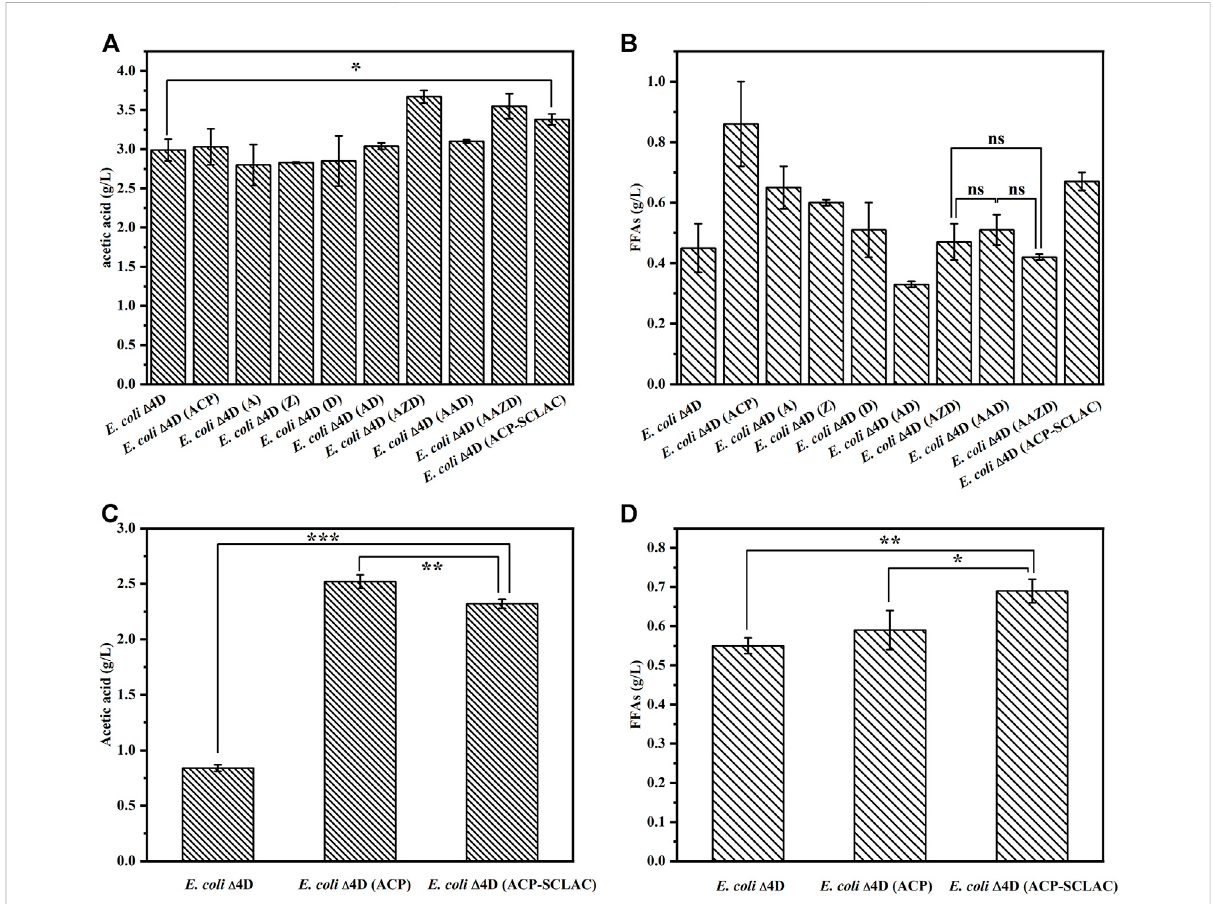
FIGURE 4 The production of acetic acid and FFAs by the engineered E. coli using different substrates. (A) The production of acetic acid by engineered E. coli using 10 g/L xylose as substrates for 64 h. (B) The production of FFAs by engineered E. coli using 10 g/L xylose as substrates for 64 h. (C) The production of acetic acid by engineered E. coli using lignocellulosic hydrolysate as substrates for 64 h. (D) The production of FFAs by engineered E.coli usinglignocellulosichydrolysateassubstratesfor64 h.Theerrorbarsindicatethestandarddeviationoftriplicateexperiments.* p < 0.05; ** p < 0.01; *** p < 0.001; ns, no signi fi